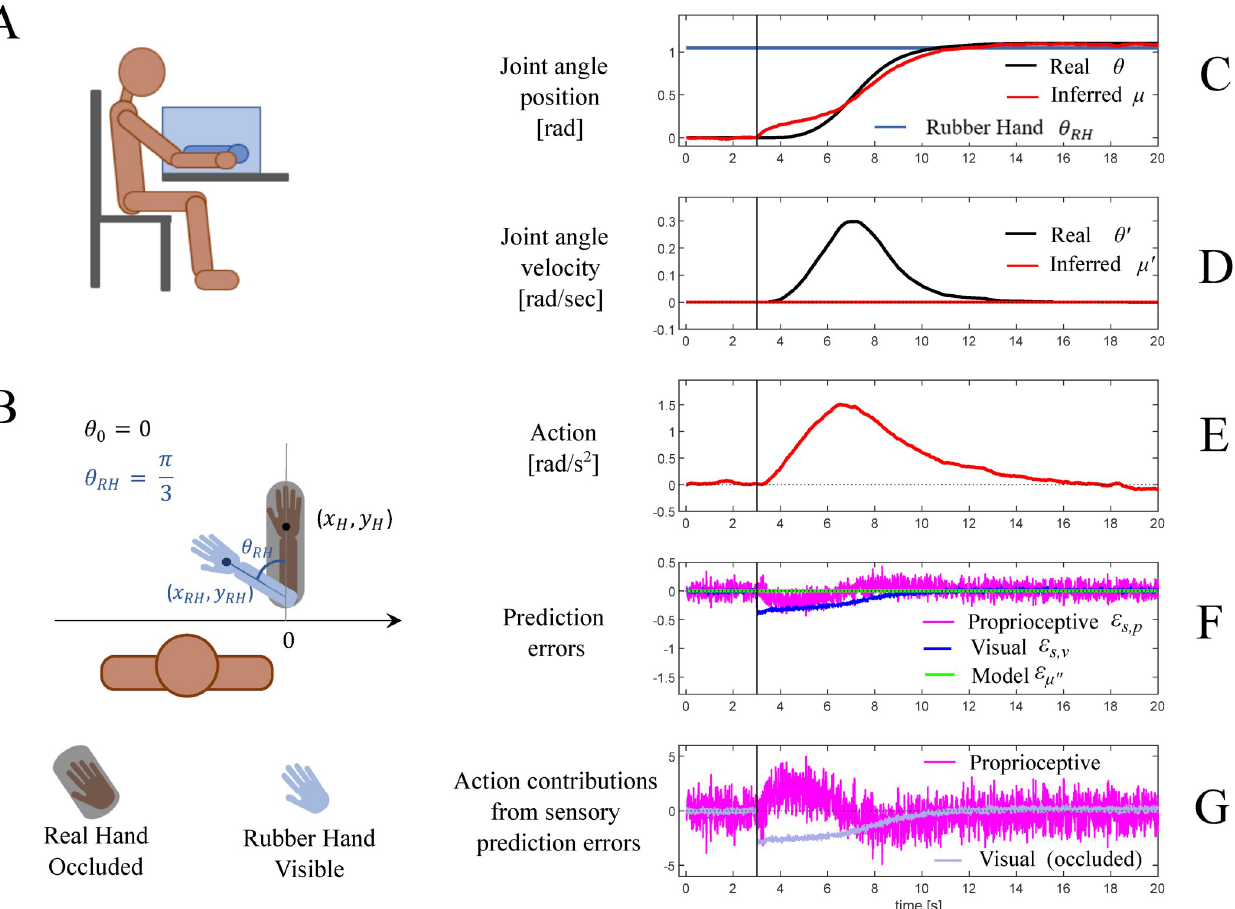
Fig 8. Second simulation: multisensory conflict in the rubber hand illusion (RHI). Schematic representation of the agent seeing a virtual hand through a virtual reality stereoscopic headset. (B) Task specification. The agent undergoes a body ownership illusion over a virtual arm shown with a rotation θ respect the real arm initial position. (C-G) Dynamics of the model variables during the task. The vertical bars mark the time of the illusion onset. (C) Joint angle of the real (black) and inferred (red) arm configurations, expressed in radians; the blue line represents the virtual arm configuration θ and inferred (red) velocity of the elbow joint angle velocity. (E) Action, represented in our model as an angular acceleration. (F) The three prediction errors considered in the model: the model dynamics error (green) and the two sensory errors, proprioceptive (magenta) and visual (blue). Please note that in this plot, the prediction error units correspond to different dimensions. (G) Contributions of proprioceptive (magenta) and visual (blue) prediction errors in determining the action, more specifically the two addends in the r.h.s. of Eq G4 in Fig 6. The gray line represents the potential visual contribution that is set off by assuming that k = 0. See the main text for A,v